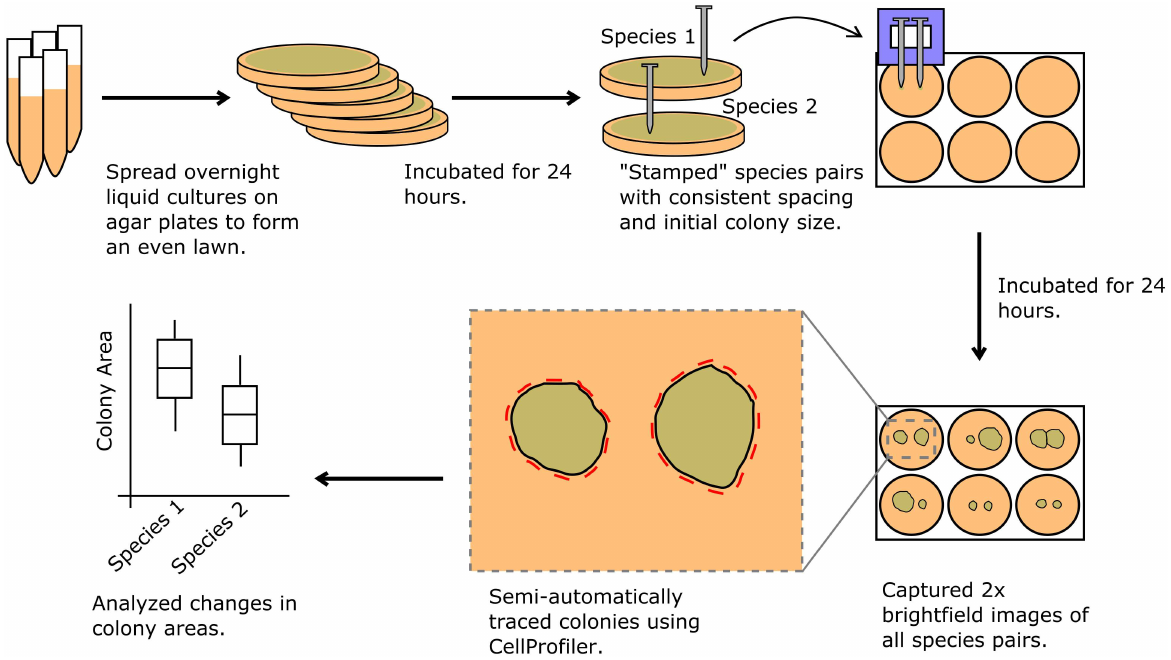
Fig 1. Workflow description. All five species were grown in overnightliquidcultures. Cultures were diluted with fresh media, spread evenly over agar plates and incubatedfor 24 hours to grow into lawns. We deviseda stampingmechanism to maintainconsistent spacing and sizes of initial colonies.Nails were used to lift cells from the lawns. The nails were placedinto slots in a 3D-printed stamping mechanismand cells were carefully “stamped” onto fresh BHI agar pouredin 6-wellplates. In the control condition, all five species were grown alone, and all pairwisecombinations were grown together (six replicates were performed of each condition).For the BaP condition,the procedurewas identicalexcept that BaP was addedto the growth media. The stamped colonieswere incubatedfor 24 hours and the resulting colonieswere imaged at 2x magnification. The images were automatically segmented and colony areas calculatedusing image analysissoftware (see Materialsand